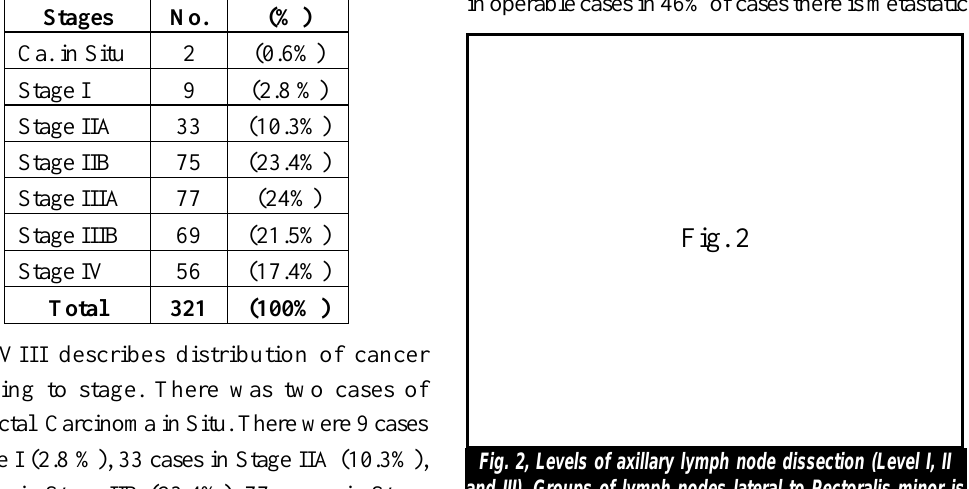
Fig. 2, Levels of axillary lymph node dissection (Level I, II and III). Groups of lymph nodes lateral to Pectoralis minor is level I, behind it is level II and medial to it is level